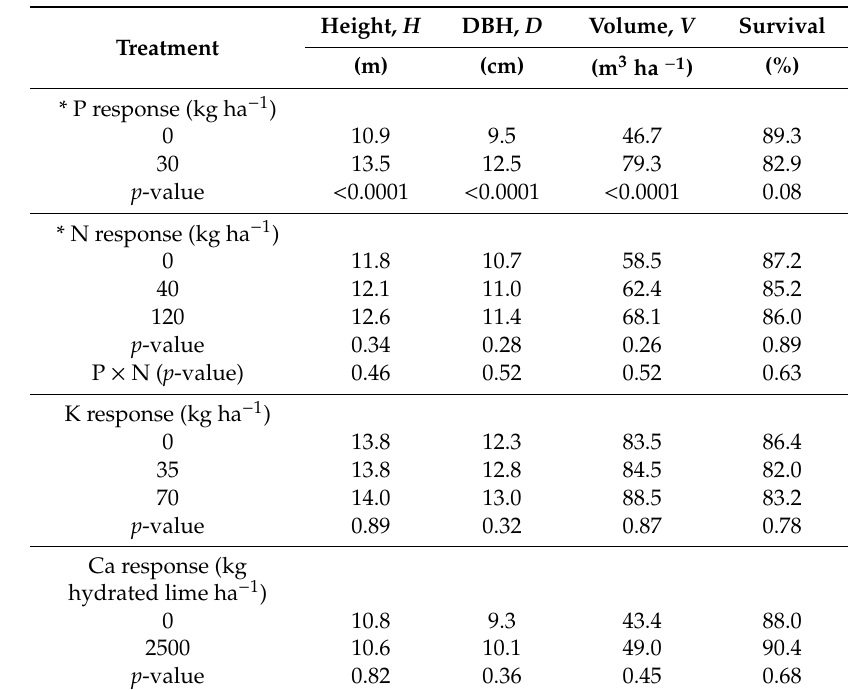
Table 4. Growth and survival of Eucalyptus pellita to various fertiliser treatments at the Core experiment at Gemawang at 3 years of